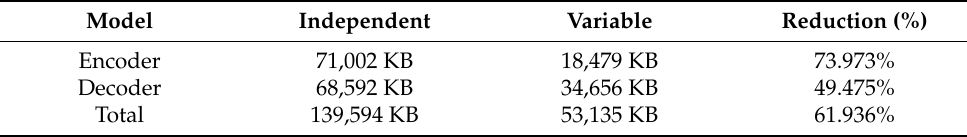
Table 1. Storage space overhead comparison of independent vs variable auto-tiler